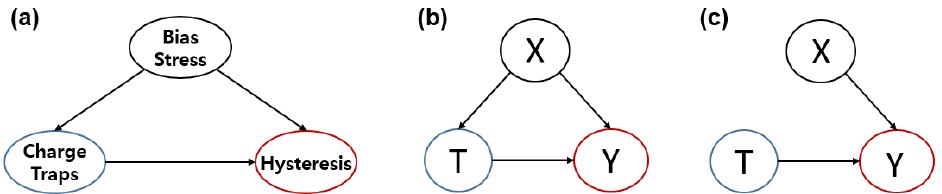
Figure 13. ( a ) Example of causal structure of hysteresis: the bias stress is a common cause of charge traps and the hysteresis, ( b ) Structure of substituting the nodes of ( a ) with variables X (covariate), T (treatment), and Y (result). ( c ) Causal structure when the treatment assignment mechanism is ignorable. Notably, this means there is no arrow from X to T and thus no